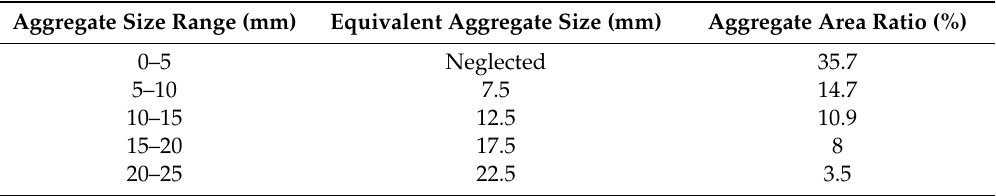
Table 1. Aggregate size distribution in a mesoscale model of ordinary